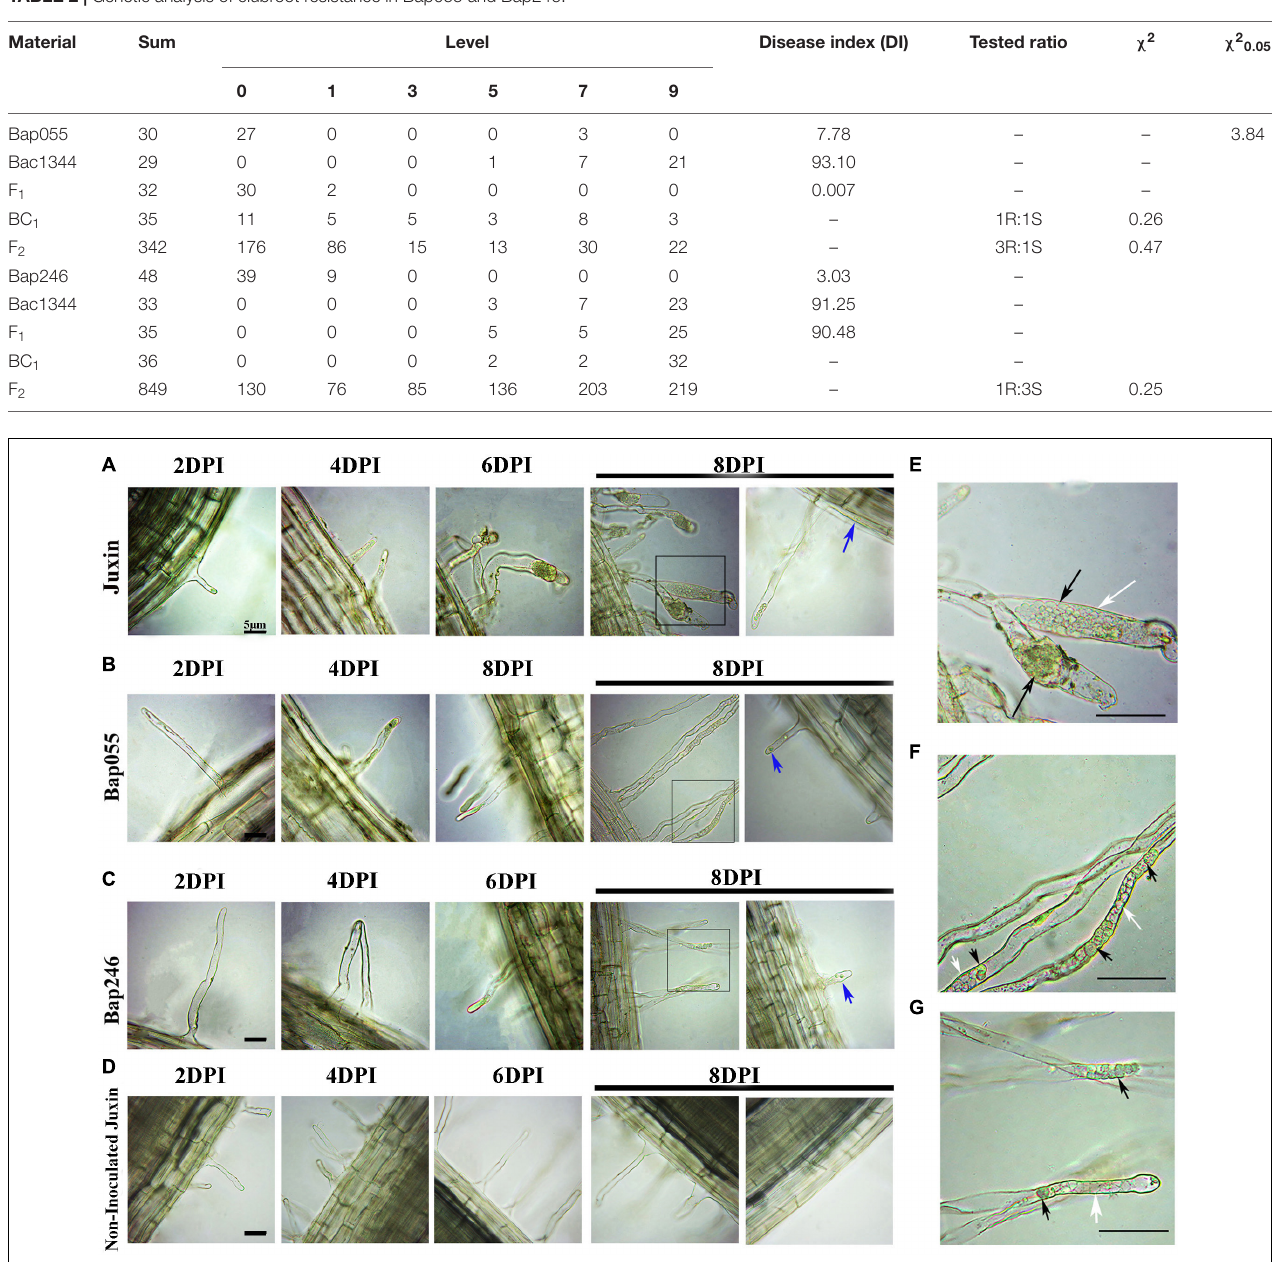
FIGURE 3 | Differences in the primary infection were investigated in the host genotypes Bap055, Bap246, and “Juxin” at 2–8 days post-inoculation (DPI). (A) Inverted microscopy images showing primary infection of “Juxin” at 2–8 DPI. (B) Primary infection of Bap055 at 2–8 DPI. (C) Primary infection of Bap246 at 2–8 DPI. (D) Inverted microscopy images of non-infected “Juxin” at 2–8 days, no invasion of P. brassicae. The part highlighted with a black box in the lower panel was further enlarged for a view in (E–G) . (E) Multinucleate zoosporangial plasmodia at “Juxin” was profiled. (F) Multinucleate zoosporangial plasmodia at Bap055 was profiled. (G) Multinucleate zoosporangial plasmodia at Bap246 was profiled. Zoosporangia with content are indicated with black arrows, while some empty zoosporangia without any content are indicated with white arrows, blue arrows indicate secondary